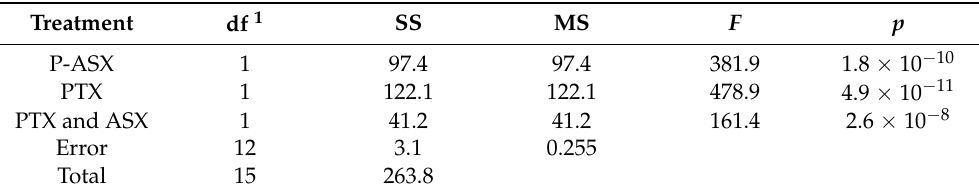
Table 1. Two-ways ANOVA analysis of the antioxidant effects of PTX and ASX microparticles given alone or in combination to J774A.1 cells.